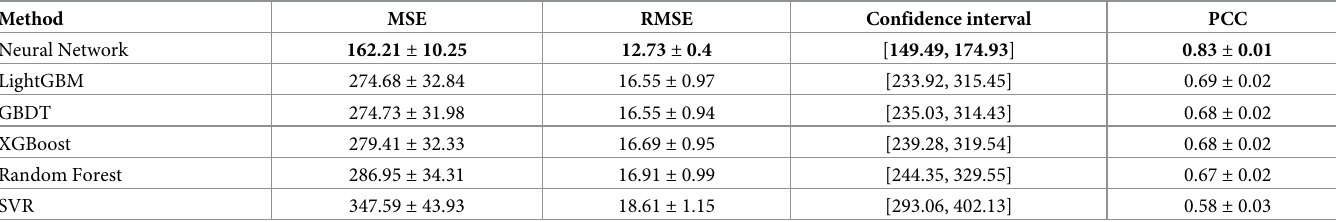
Table 4. The performances of different predictors for